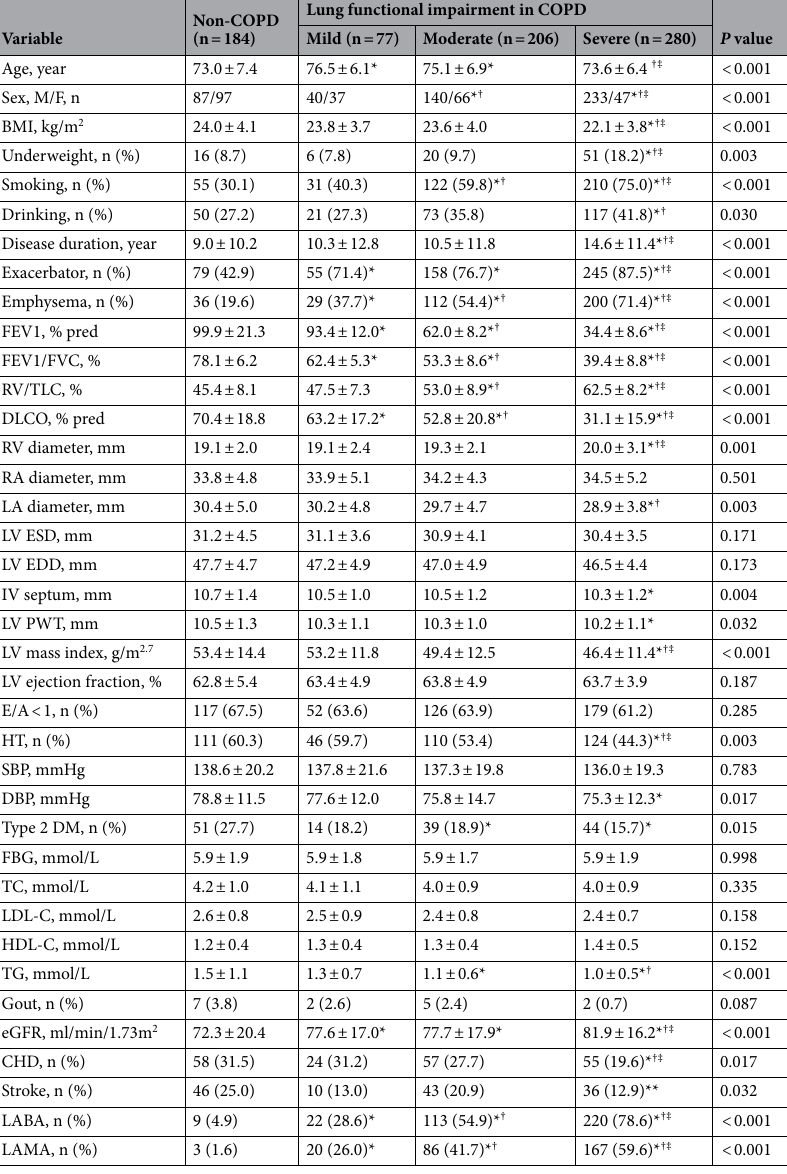
Table 1. Comparison of clinical characteristics among different lung dysfunction categories in COPD. Values presented as mean ± SD or n (%).* p < 0.05 versus non-COPD group; † p < 0.05 versus mild lung functional impairment group; ‡ p < 0.05 versus moderate lung functional impairment group. COPD, chronic obstructive pulmonary disease; BMI, body mass index; FEV1, forced expiratory volume in one second; FVC, forced vital capacity; RV, residual volume; TLC, total lung capacity; DLCO, diffusing capacity of carbon monoxide; RV, right ventricular; RA, right atrial; LA, left atrial; LV ESD, left ventricular end-systolic diameter; LV EDD, left ventricular end-diastolic diameter; IV, interventricular thickness at the end-diastole; LV PWT, left ventricular posterior wall thickness at the end-diastole; LV, left ventricular; E/A: transmitral peak early (E) and late (A) filling velocity ratio; HT, hypertension; SBP, systolic blood pressure; DBP, diastolic blood pressure; DM, diabetes mellitus; FPG, fast plasma glucose; TC, total cholesterol; LDL-C, low density lipoprotein cholesterol; HDL-C, high density lipoprotein cholesterol; TG, triglyceride; eGFR, estimated glomerular filtration rate; CHD, coronary heart disease; LABA, Long-acting β2 adrenergic receptor agonist; LAMA, Long-acting muscarinic